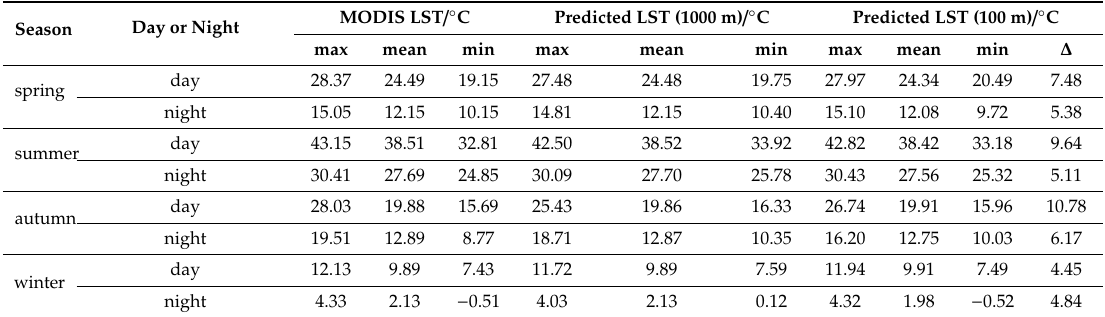
Table 5. Ranges of LST during daytime (Figure 14) and at night (Figure 15) of all research dates.